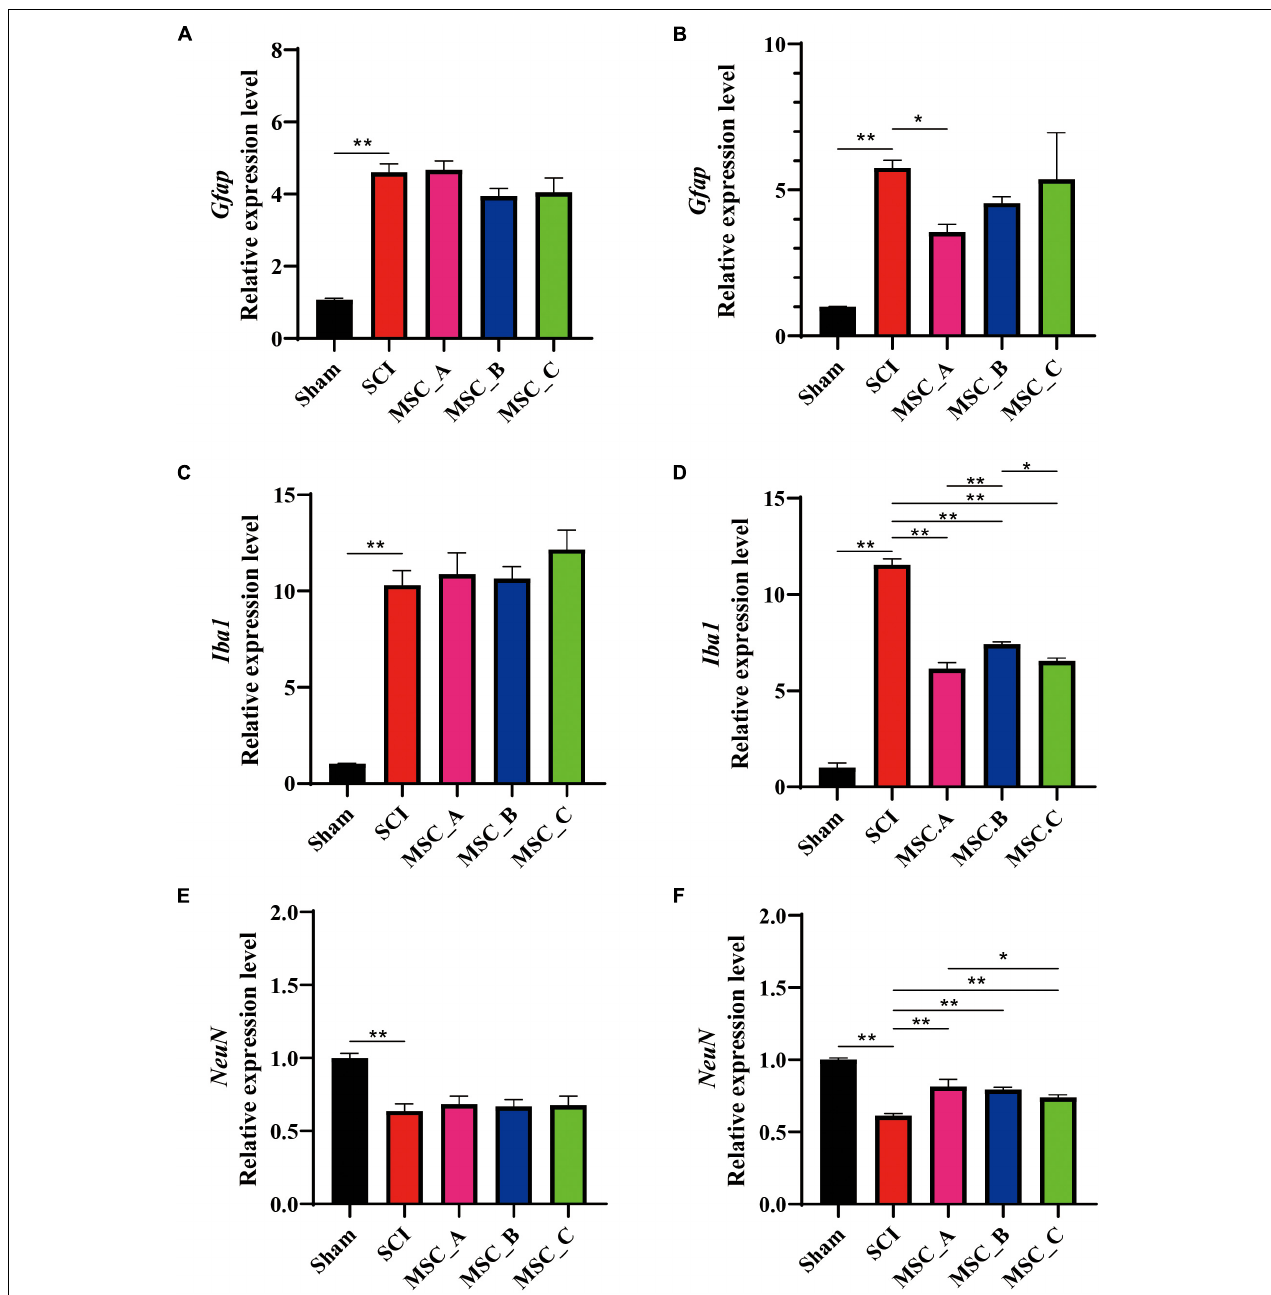
FIGURE 4 | The qualitative polymerase chain reaction (q-PCR) showing the changes in mRNA related to SCI at 1 week and 1 month after hUCMSC treatment at dpo 3. The mRNA expressions of Gfap (A) , Iba1 (C) , and NeuN (E) at 1 week after hUCMSC transplantation. The mRNA expressions of Gfap (B) , Iba1 (D) , and NeuN (F) at 1 month after hUCMSC transplantation. All data are presented as the mean ± SEM; n = 3; * p < 0.05; ** p <